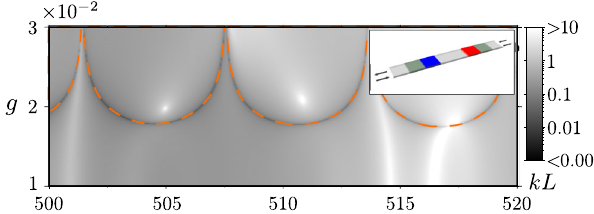
FIG. 5. Difference between the two scattering-matrix eigen- values D ð kL; g Þ (cid:6) j (cid:1) 1 (cid:2) (cid:1) 2 j for the PT -symmetric two-layer system shown in Fig. 1(a) with two slabs of width L= 4 attached on either side (see also the smaller inset). The slabs feature randomly chosen complex refractive indices that satisfy n ð P x Þ , where R ( L ) stands for the slab on the right n L (left) side of the PT -symmetric structure. The lines where D ¼ 0 , i.e., where (cid:1) 1 ¼ (cid:1) 2 , coincide exactly with the exceptional line of the inner PT -symmetric part of the system (dashed orange